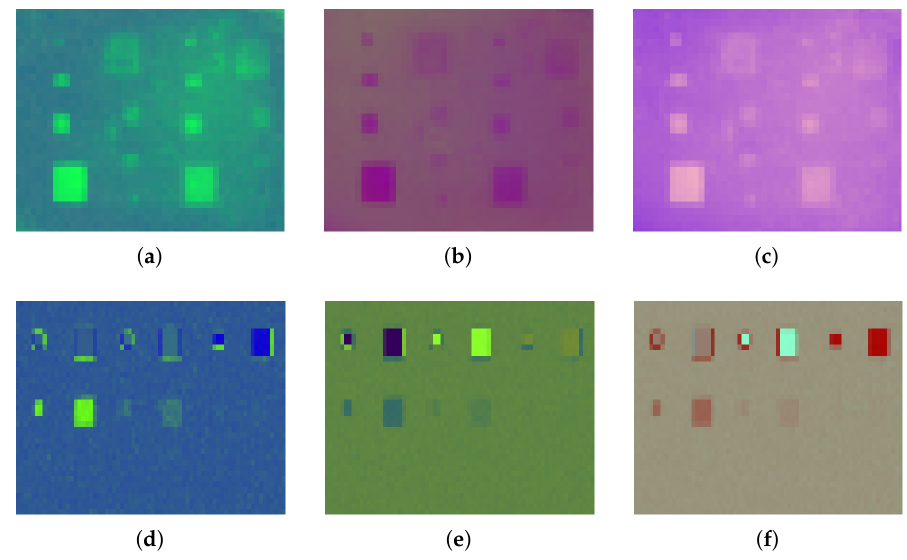
Figure 9. Results obtained with the application of QPCA processing to the sequence colorized by Gaussian KPCA: ( a ) σ = 0.1 and frame 2, ( b ) σ = 1 and frame 3, ( c ) σ = 1 and frame 3, ( d ) σ = 0.1 and frame 2, ( e ) σ = 0.1 and frame 2, ( f ) σ = 0.5 and frame 1.